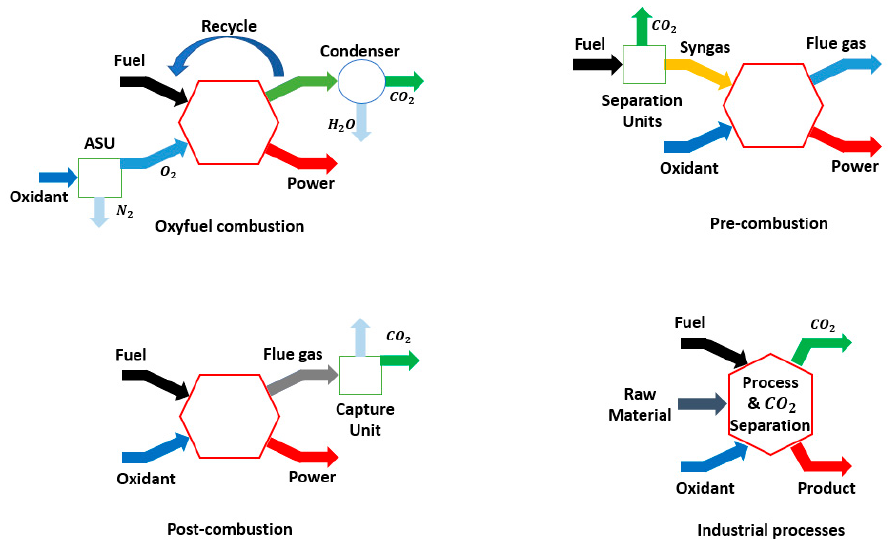
Figure 1. Schematic diagrams of carbon capture processes showing oxyfuel combustion, pre-combustion, and post-combustion applied to the energy sector, while the last diagram illustrates a general CO 2 separation process for a net-zero industry.